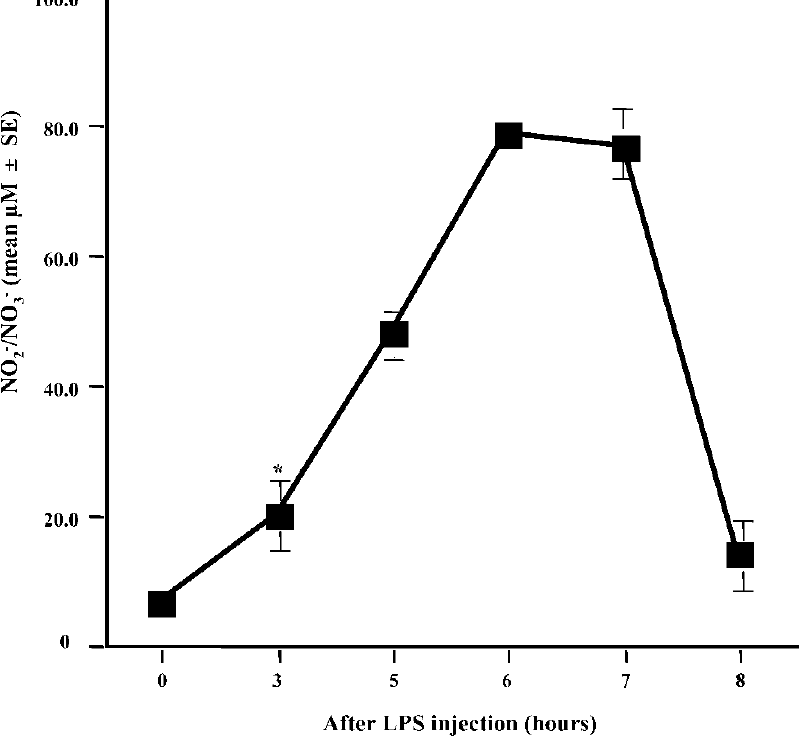
FIG. 1. Time course of NO (NO 2 (cid:1) /NO 3 (cid:1) ) generation after LPS injection in mice. ICR mice were injected intraperitoneally with 5.0 mg/kg of LPS, and plasma NO 2 (cid:1) /NO 3 (cid:1) levels were examined at 3, 5, 6, 7, and 8 h after injection. The data are expressed as the mean ( m M) 9 / standard error of five mice. * Significant compared with normal control (0